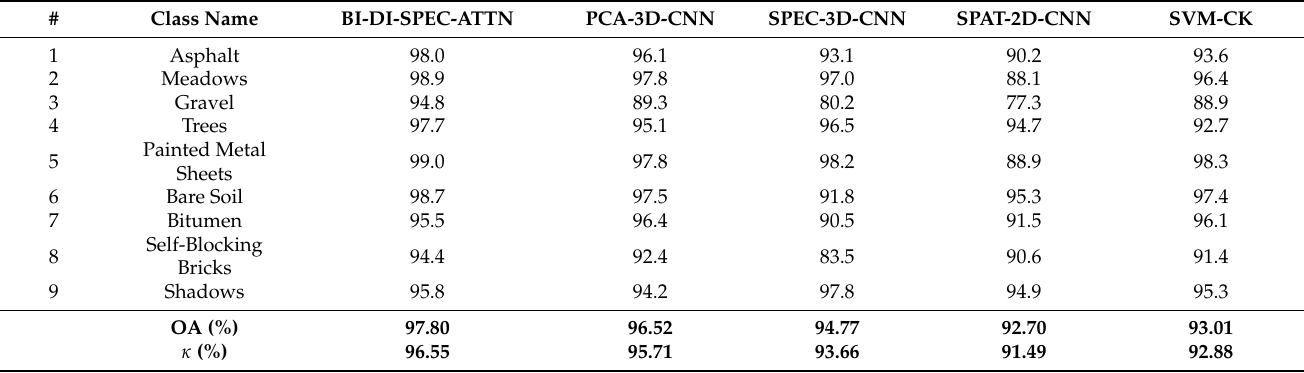
Table 5. Class-specific accuracies of Pavia University dataset with 10% of training data for the proposed methodology and other models used for